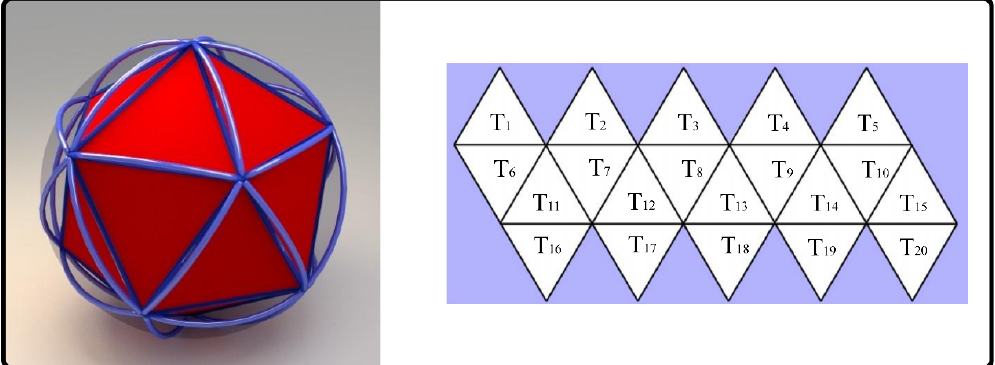
Figure 14. The icosahedron version of the initial global grid and region index.